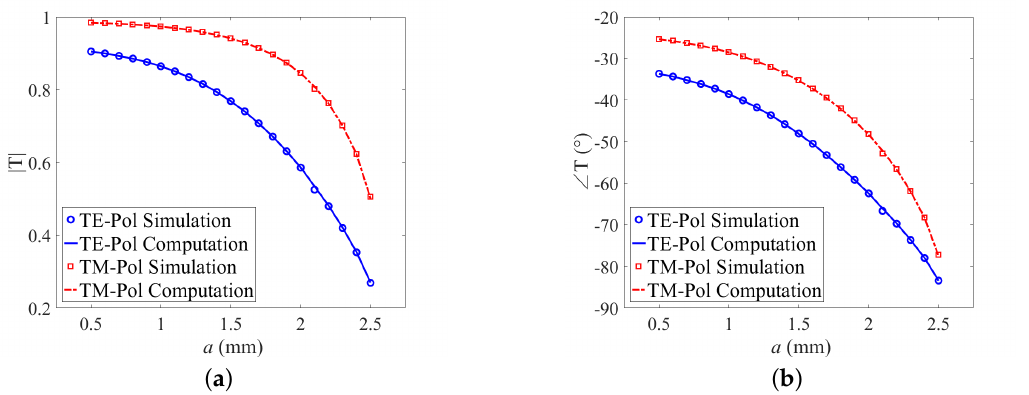
Figure 13. Comparison between simulated and computed transmission coefficients of the unit cell shown in Figure 11 with θ = 45 ◦ at 10 GHz: ( a ) magnitude, ( b )